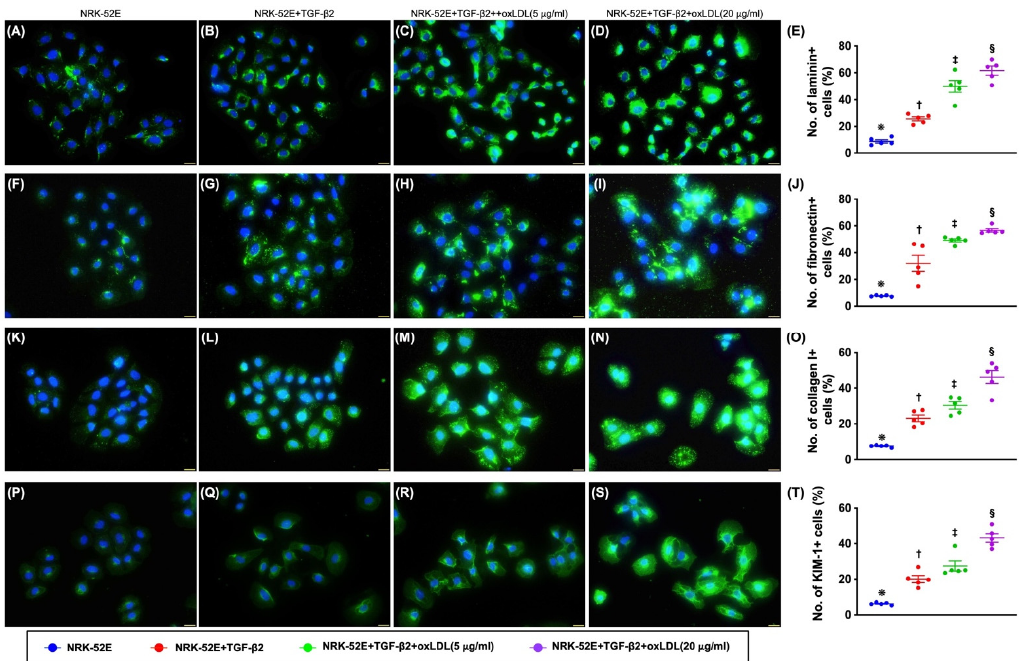
Figure 2. Cellular levels of fibrosis/ECM and kidney injury biomarkers in NRK-52E cells treated by TGF- β and oxidized LDL. ( A – D ) Illustrating the immunofluorescent (IF) stain of microscopic finding (400×) for identification of cellular expression of laminin (green color). ( E ) Analytical result of number (%) of laminin+ cells, * vs. other groups with di ff erent symbols (†, ‡, §), p < 0.001. ( F – I ) Illustrating the IF stain of microscopic finding (400×) for identification of cellular expression of fibronectin (green color). ( J ) Analytical result of number (%) of fibronectin+ cells, * vs. other groups with di ff erent symbols (†, ‡, §), p < 0.001. ( K – N ) Illustrating the IF stain of microscopic finding (400×) for identification of the expression of collagen I (green color). ( O ) Analytical result of number (%) of collagen I+ cells, * vs. other groups with di ff erent symbols (†, ‡, §), p < 0.001. ( P – S ) Illustrating the IF microscopic finding (400×) for identification of cellular expression of kidney injury molecule-1 (KIM-1) (green color). ( T ) Analytical result of number (%) of KIM-1+ cells, * vs. other groups with di ff erent symbols (†, ‡, §), p < 0.001. Scale bars in right lower corner represent 20 μ m. All statistical analyses were performed by one-way ANOVA, followed by Bonferroni multiple comparison post hoc test (n = 5 for each group). Symbols (*, †, ‡, §) indicate signi fi cance for each other (at 0.05 level).